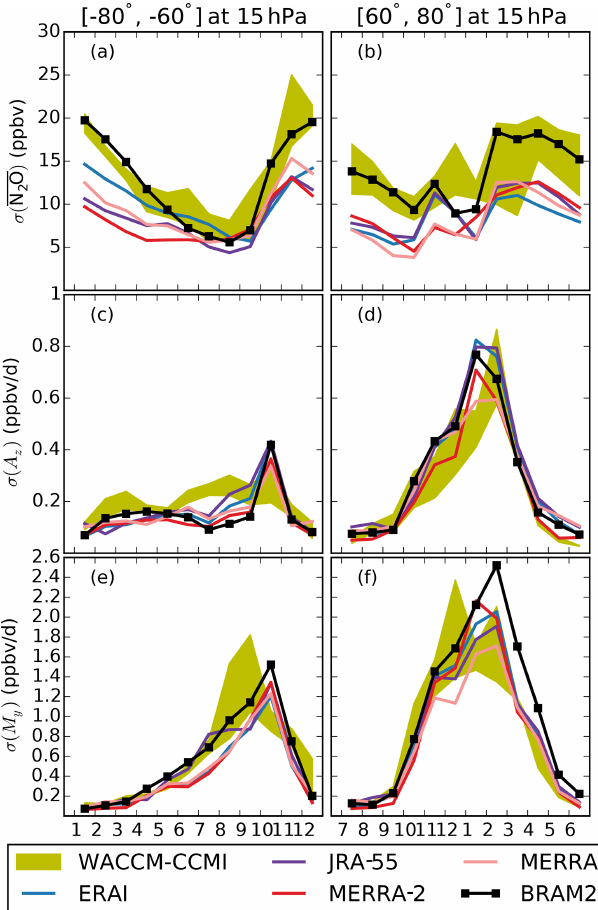
Figure 10. Monthly standard deviation over the 2005–2014 period at 15hPa for (a, b) the N 2 O volume mixing ratio (ppb), (c, d) the horizontal mixing term (ppbvd − 1 ) and (e, f) the vertical residual advection term (ppbvd − 1 ) in (a, c, e) the Antarctic region (60– 80 ◦ S) and (b, d, f) the Arctic region (60–80 ◦ N). The color code is shown in the legend. The yellow envelope shows the three real- izations of the WACCM-CCMI